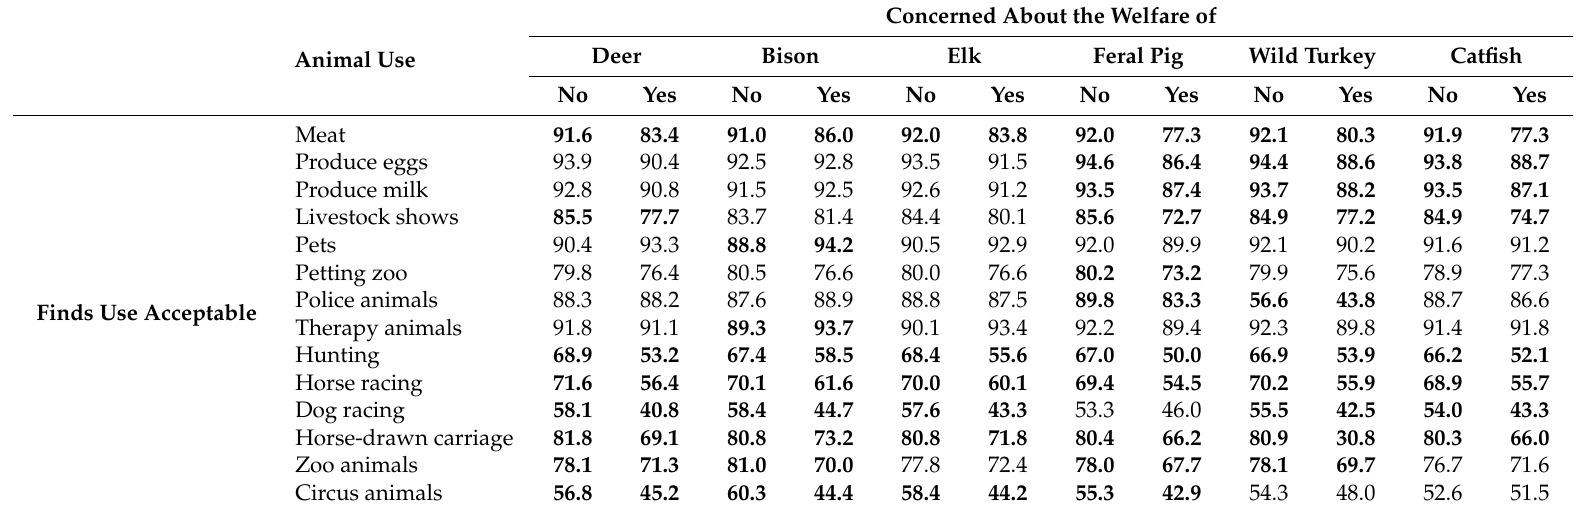
Table 7. Cross tabulations between concern for the welfare of wild animals and acceptance of animal